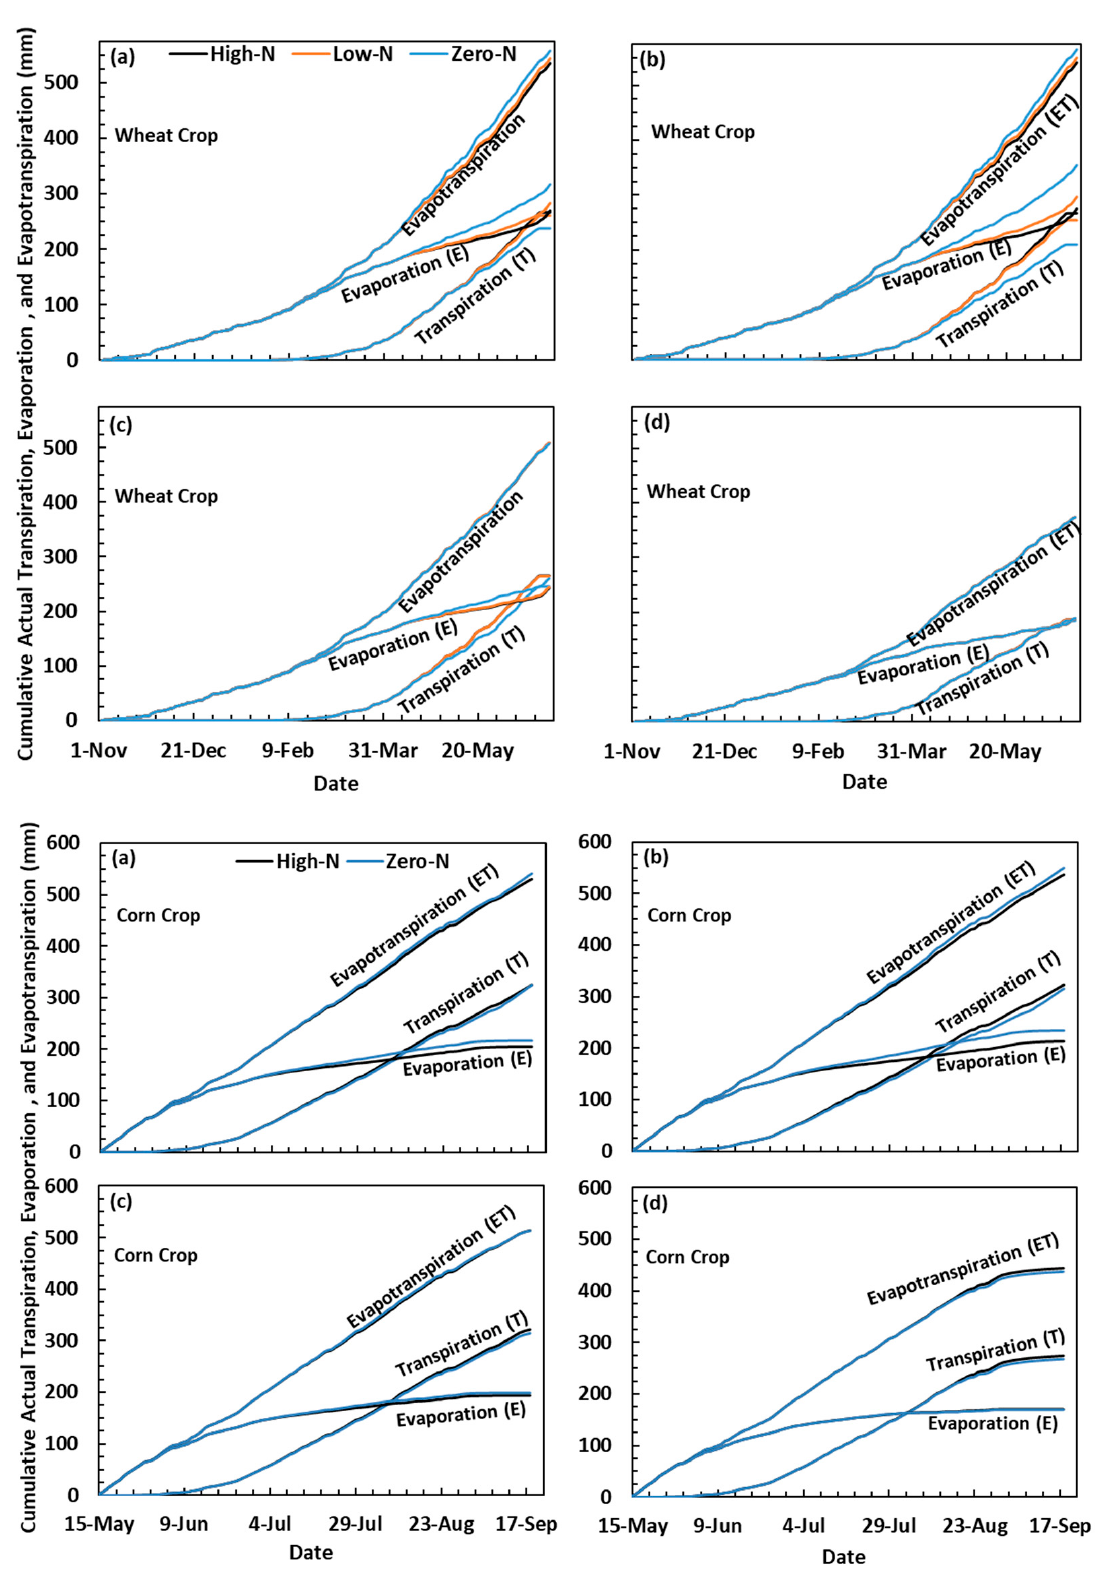
Figure 10. Cumulative actual transpiration, evaporation, and evapotranspiration (mm) for the wheat and corn growing seasons under the: ( a ) 100%, ( b ) 125%, ( c ) 75% and ( d ) 50% rainfall scenarios.